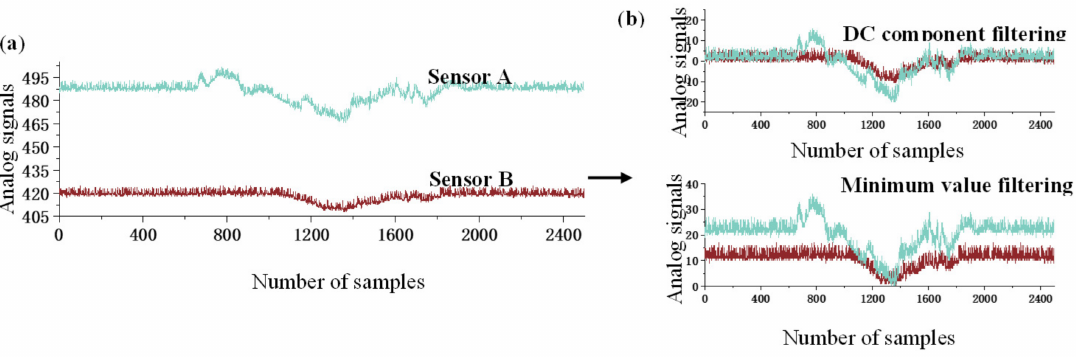
Figure 2. Data preprocessing process diagram. ( a ) Waveform diagram of the original tactile signal; ( b ) Waveform diagram of the tactile data after